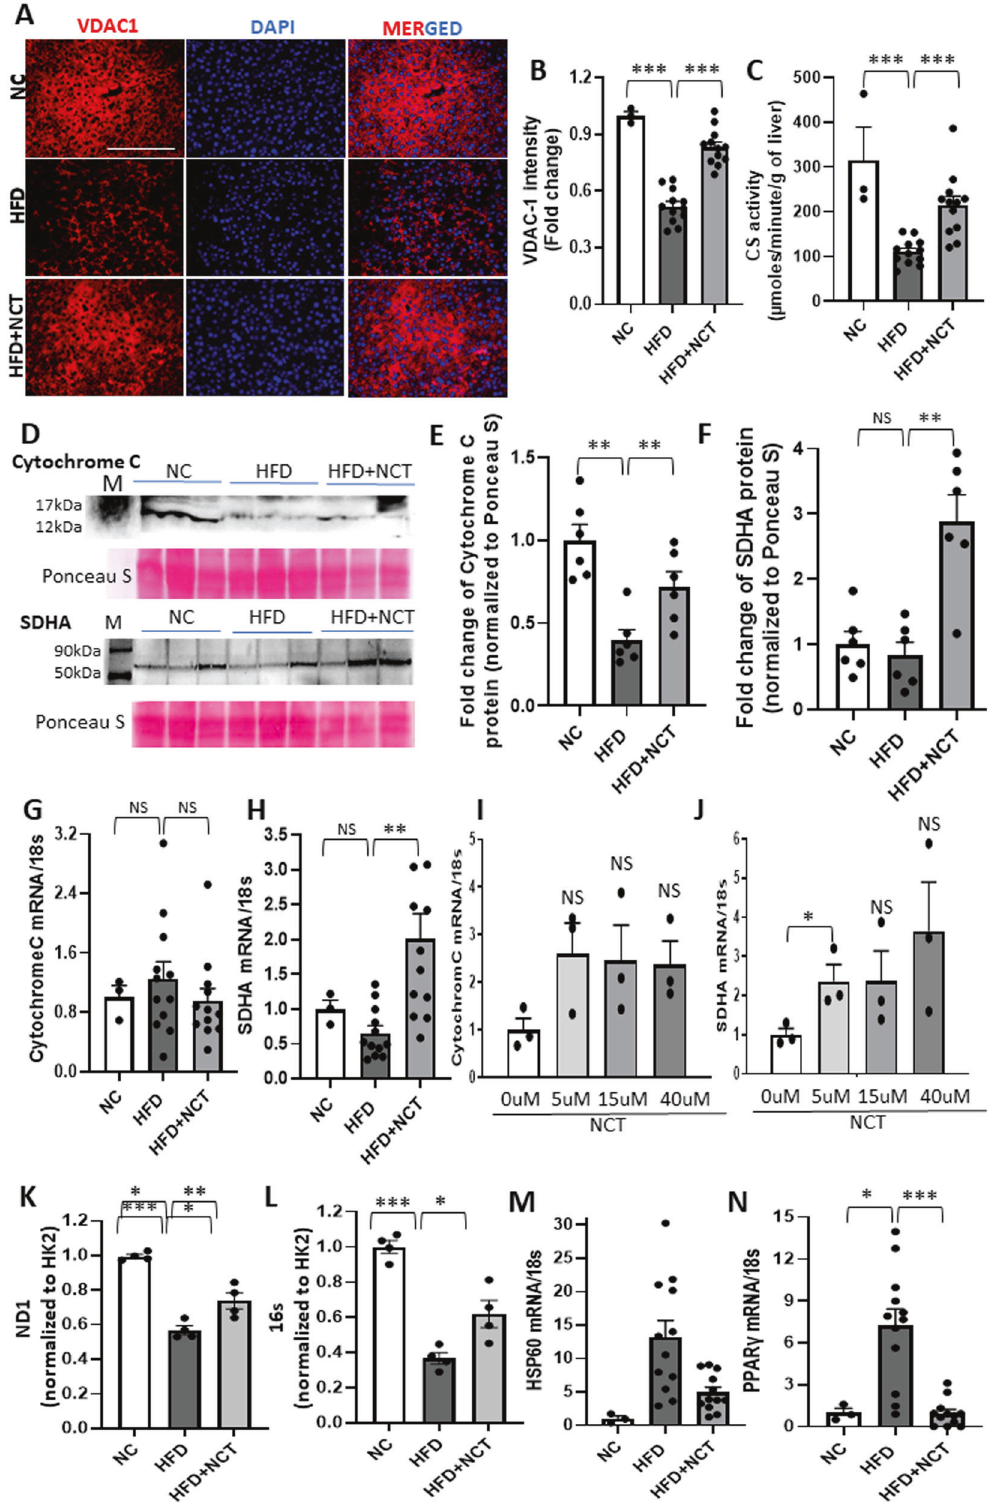
command, the threshold was manually set to highlight the Oil red O-stained lipid droplets in the green channel. We used the same threshold for all the images in all treatment groups and the % oil red O-stained area was obtained using the Analyze → Measure tool command. Fold change was calculated by normalizing the values to images from mice fed normal chow.